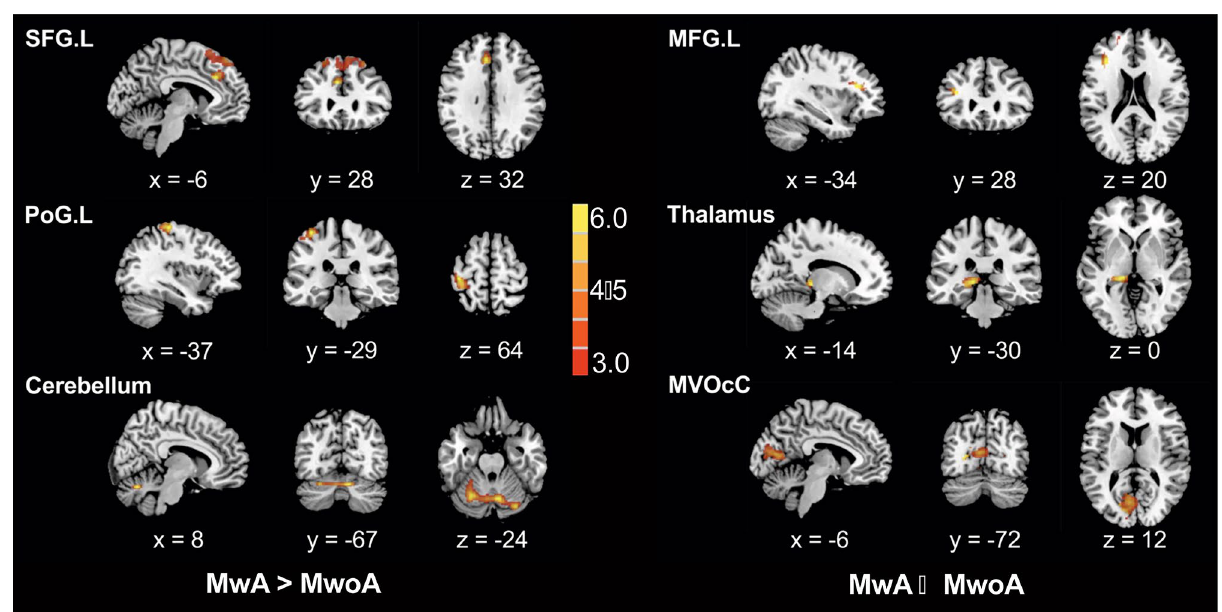
Fig. 1 Voxel-based-analysis indicated the brain regions with significant differences in normalized CBF between MwA and MwoA. Statistical threshold was set at t > 3.0 and p < 0.05, FDR corrected at cluster level. CBF: cerebral blood flow, MFG.L: left middle frontal gyrus, MVOcC: medioventral occipital cortex, MwA: migraine patients with aura, MwoA: migraine patients without aura, PoG.L: left postcentral gyrus, SFG.L: left superior frontal Correlations between extracted CBF features and clinical scale assessment